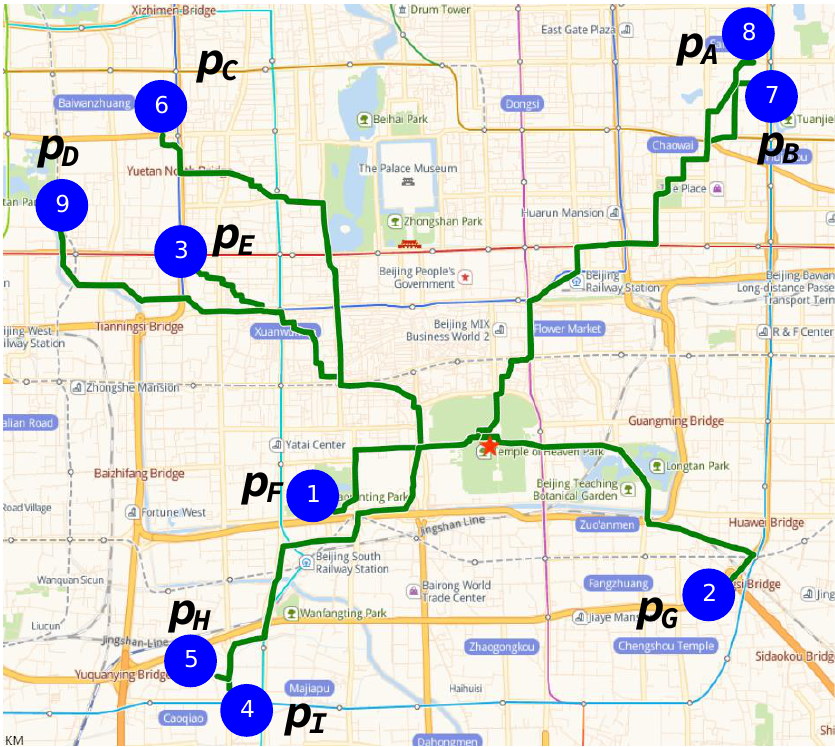
Figure 1. Demonstration of vehicle evacuation sequence based on spatial diversity ( p is the location of end for the corresponding vehicle with the number in the circle shows its evacuation